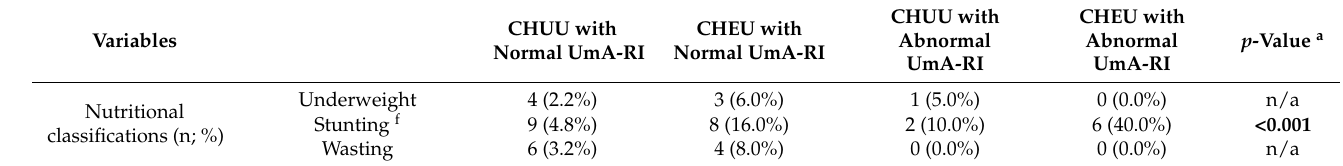
Values in bold font indicate significant p -values. Abbreviations: CHEU: children who are HIV-exposed-uninfected; CHUU: children who are HIV-unexposed-uninfected; UmA-RI: umbilical artery resistance index; HC: head circumference; MUAC: mid-upper-arm circumference; TSF: triceps skinfold; WAZ: weight-for-age z-score; LAZ: length-for-age z-score; WLZ: weight-for-length z-score; HCZ: head circumference z-score; n/a: not applicable. a Comparisons between CHEU with abnormal UmA-RI group vs. control group. Only variables with groups above 5 were included in these investigations as smaller groups lead to volatility of results. n/a implies no comparisons were made due to low counts. b Comparisons were made between the four study groups. c Comparison between CHUU with normal UmA-RI vs. CHEU with normal UmA-RI groups. d The birth sex-normalized anthropometric indicators were computed using INTERGROWTH-21 st software, using gestation-adjusted age for preterm infants. e The sex-normalized anthropometric indicators at age 18 months were computed using World Health Organization (WHO) Anthro software of 2011, using gestation-adjusted age for preterm infants. f Additionally, comparison between CHUU with normal UmA-RI vs. CHEU with normal UmA-RI: p = 0.016.